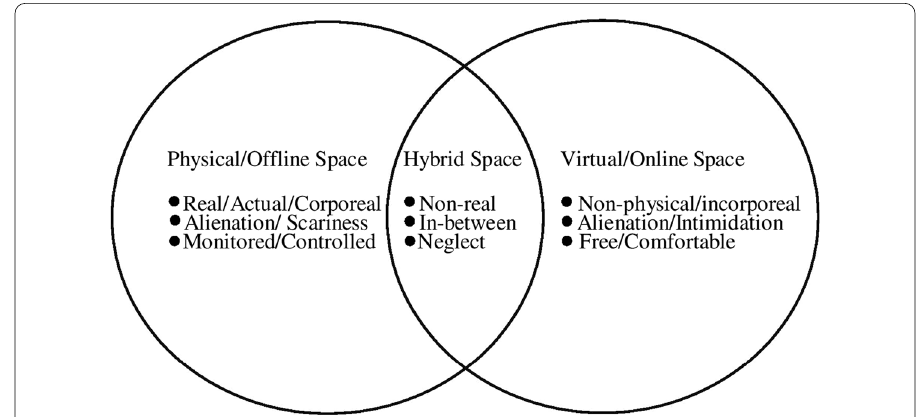
Fig. 1 The experiences of the learning